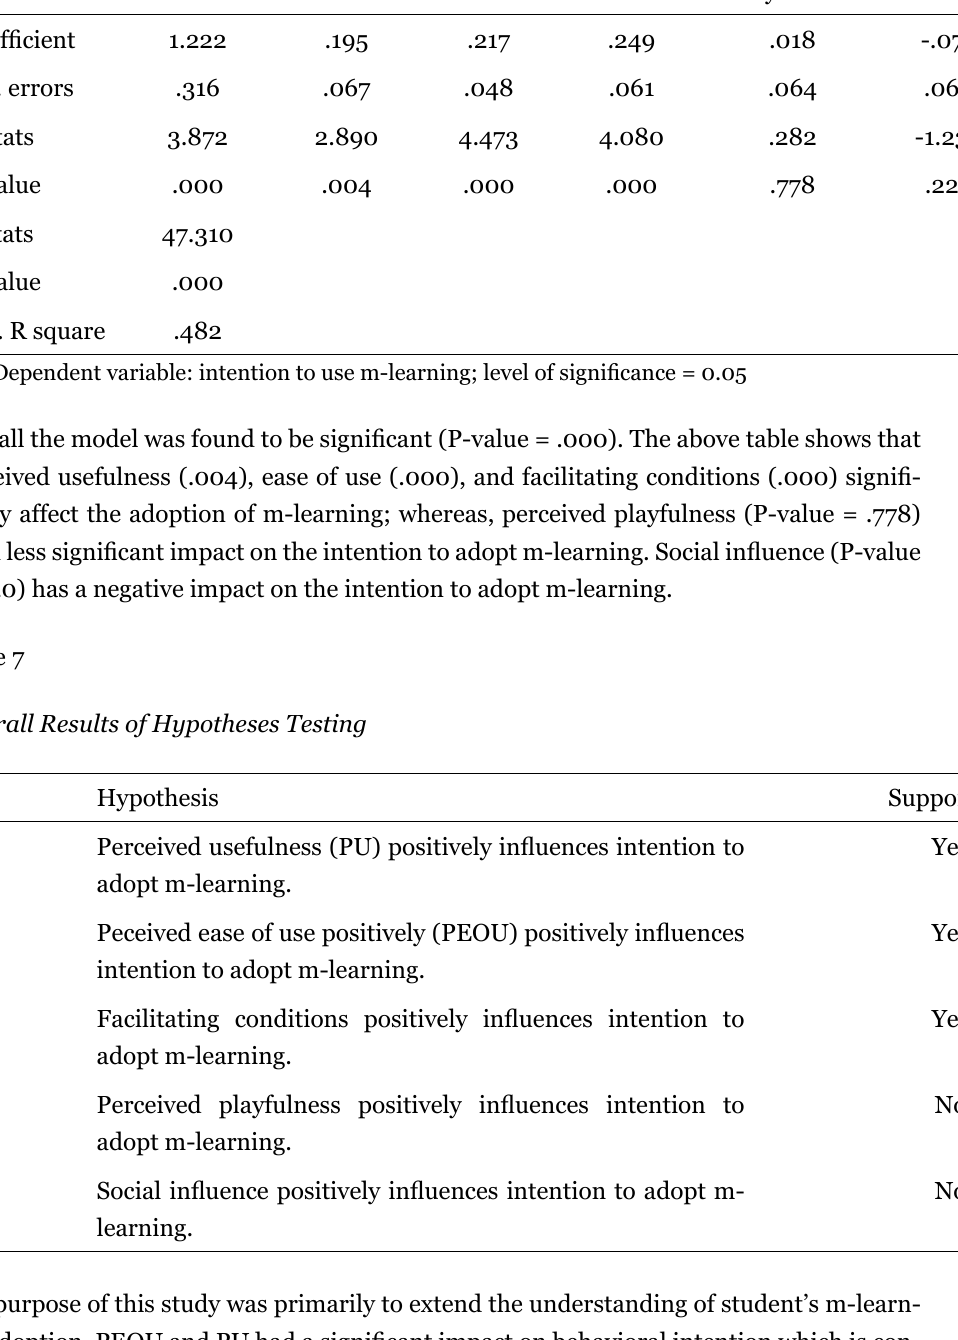
Regression Results: Coefficient, Standard Error, T-Value, and P-Value Const. Perceived Ease of Facilitating Perceived Social Usefulness Use Conditions Playfulness Influence Coefficient 1.222 .195 .217 .249 .018 -.074 Std. errors .316 .067 .048 .061 .064 .060 T-stats 3.872 2.890 -1.230 P-value .000 .004 .000 .000 .778 .220 F-stats 47.310 P-value .000